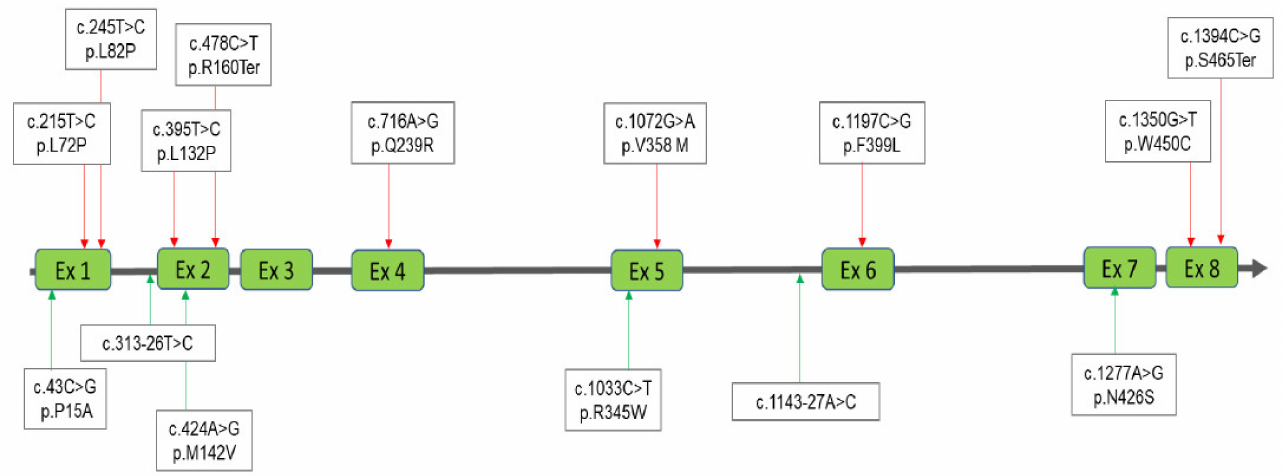
Figure 5. A total of 15 mutations of the ARSB gene underlying Taiwanese Maroteaux-Lamy syndrome were found; of those nine had been reported previously (red lines with arrows) and the other six were novel mutations (green lines with